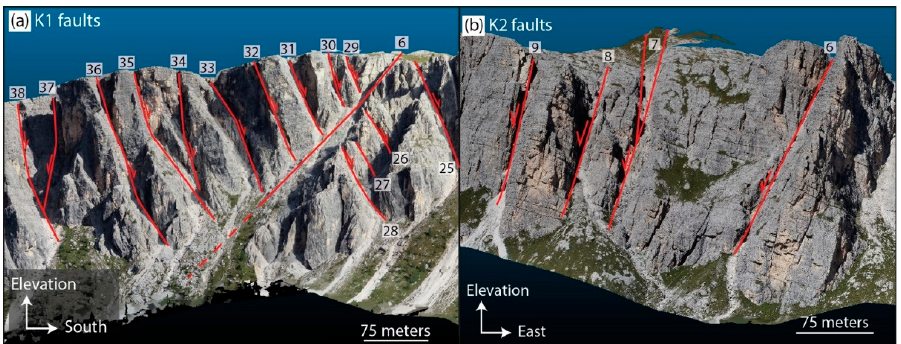
Figure 12. ( a ) Horizontal view toward east of the DOM representing the central part of the western cliff of Lastoni di Formin where the K1 faults are visible. ( b ) Horizontal view toward north of the DOM representing the eastern part of the Lastoni di Formin south wall where the main K2 faults (fault segments 7 and 8) are visible.